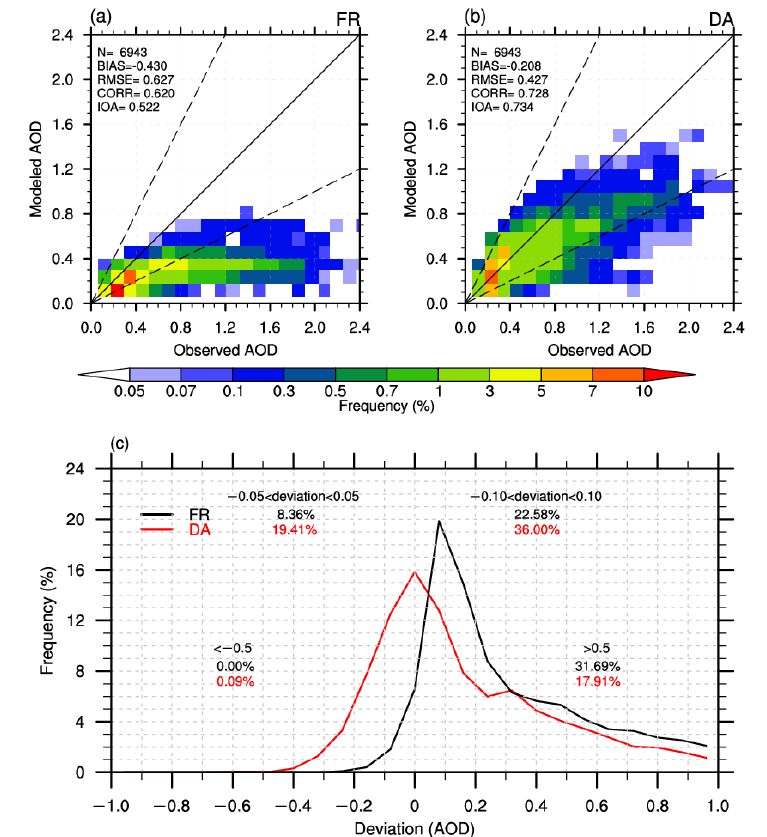
Figure 7. Probability density distribution of the observed and simulated hourly AODs for the ( a ) FR experiment and ( b ) DA experiment from 8 to 22 March 2021 at all the observational sites. The continuous black line is the 1:1 line, and the dashed black lines correspond to the 1:2 and 2:1 lines. ( c ) Frequency distributions of deviations (modeled AODs minus observed AODs) from the observations. The percentages of deviations between ±0.05, ±0.1, < − 0.5, and >0.5 are also shown.